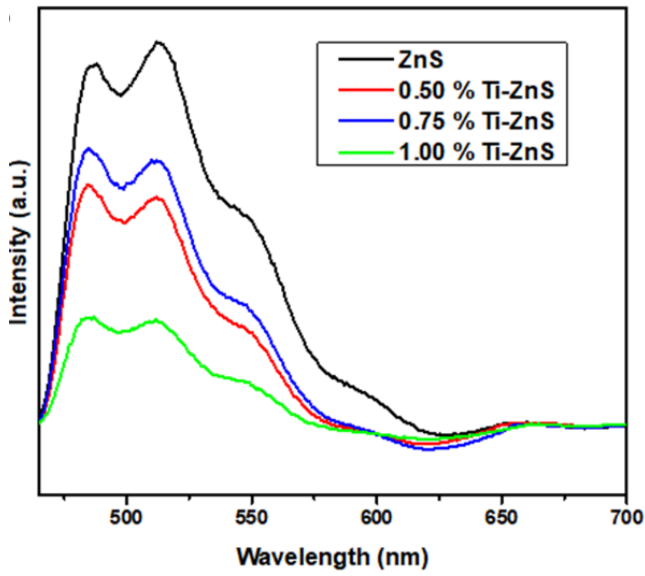
Figure 7. PL spectra of undoped ZnS and Ti-doped ZnS nanopowder samples at different concentrations.